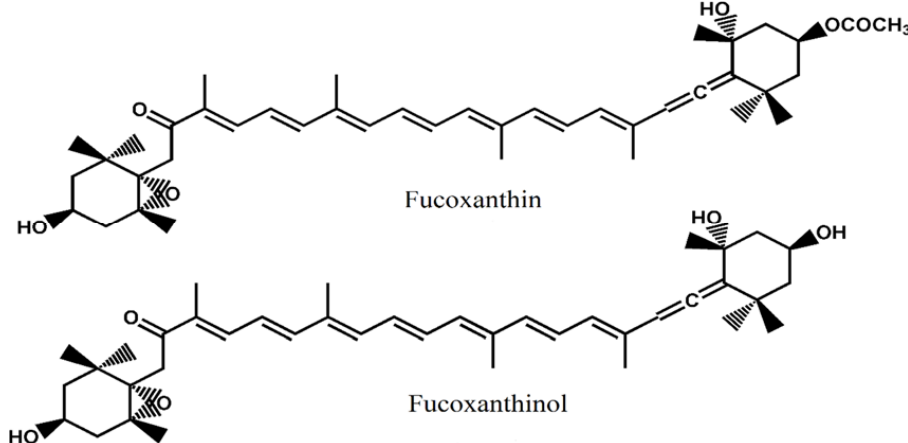
Fig. 6: The structures of Fucoxanthin and Fucoxanthinol